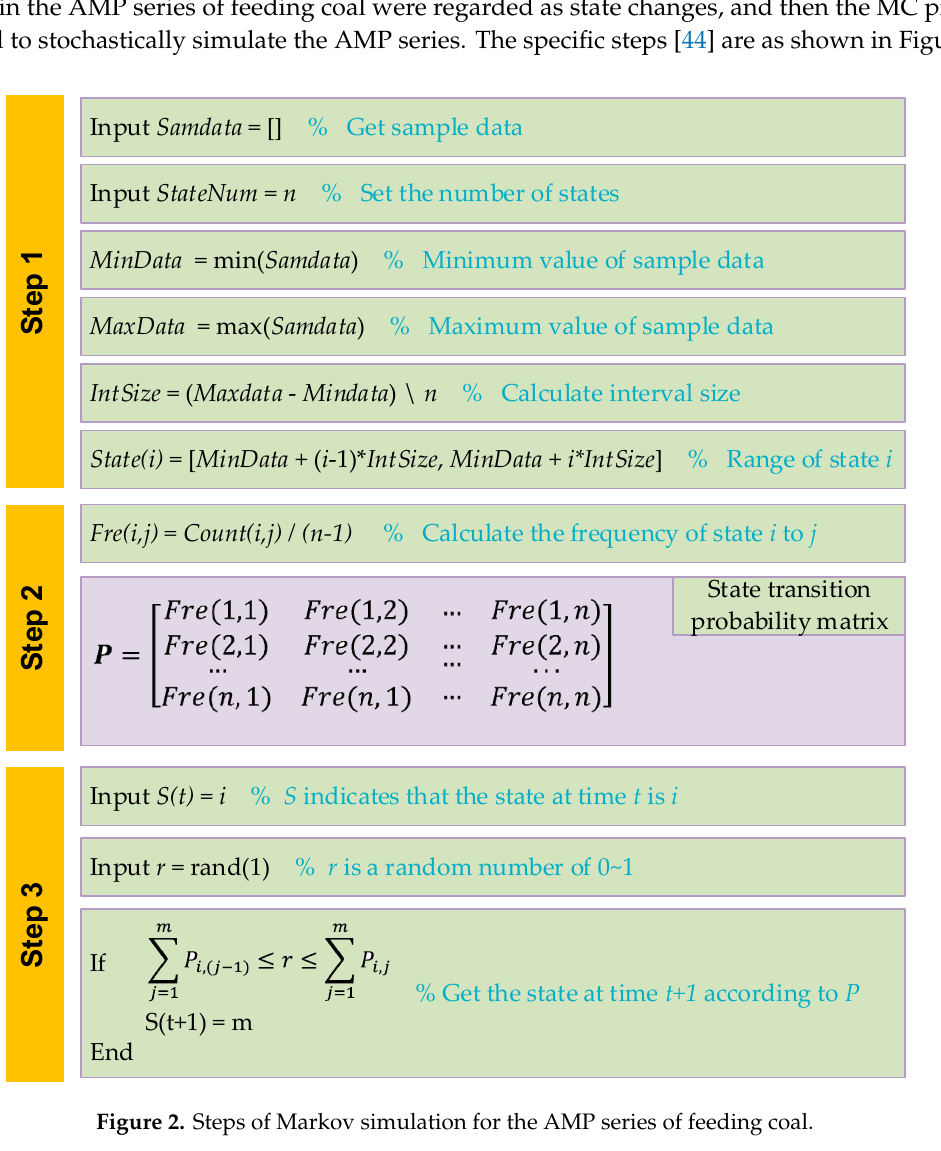
Figure 2. Steps of Markov simulation for the AMP series of feeding coal.